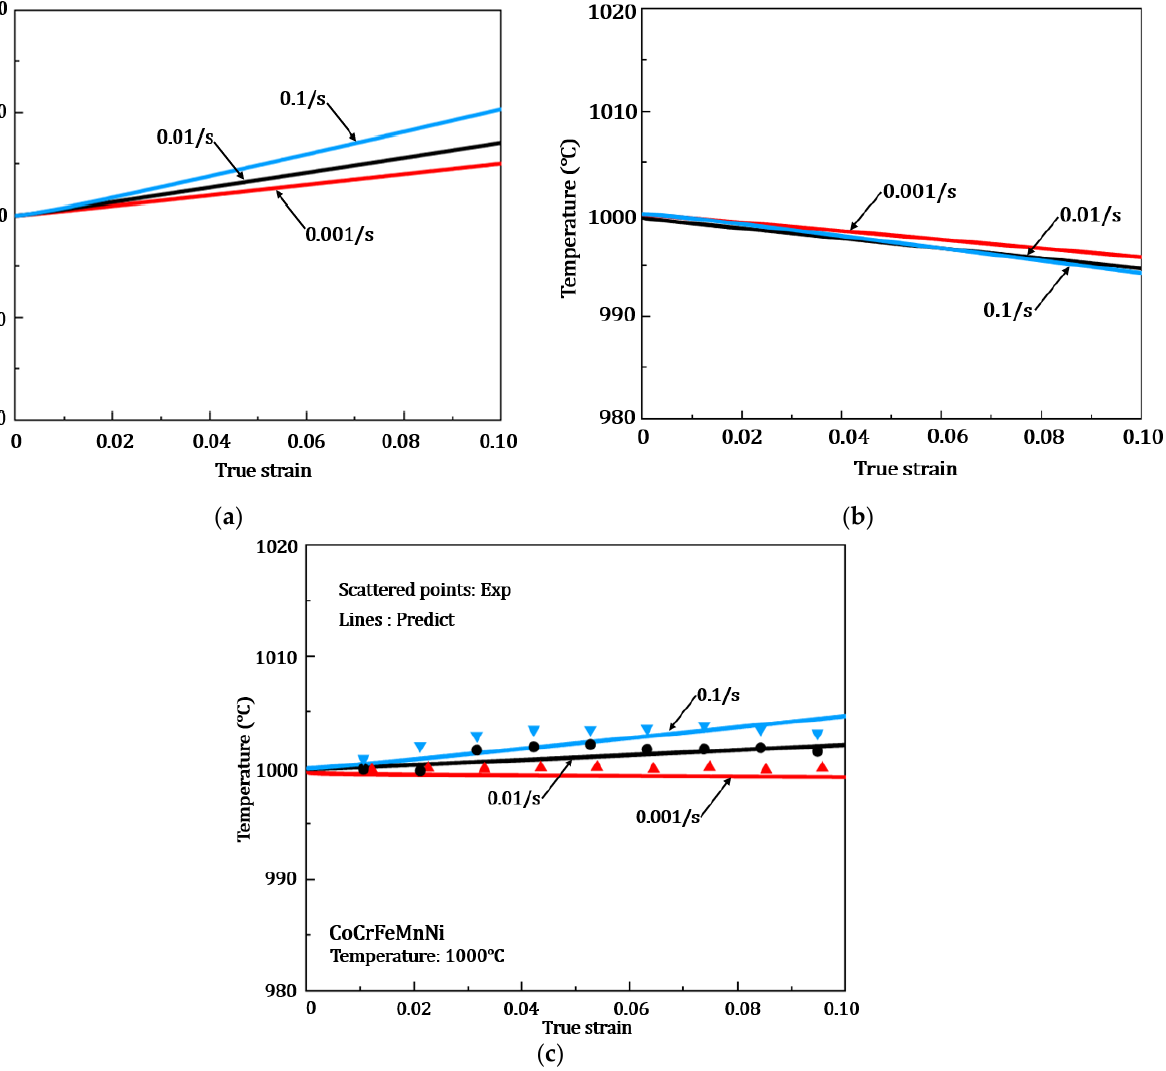
Figure 2. Comparison of experimental temperature variations and fitted predictions for different strain rates of Gleeble hot compression tensile testing: ( a ) adiabatic heat; ( b ) dissipate heat; ( c ) total temperature variation. The target testing temperature is 1000 °C.